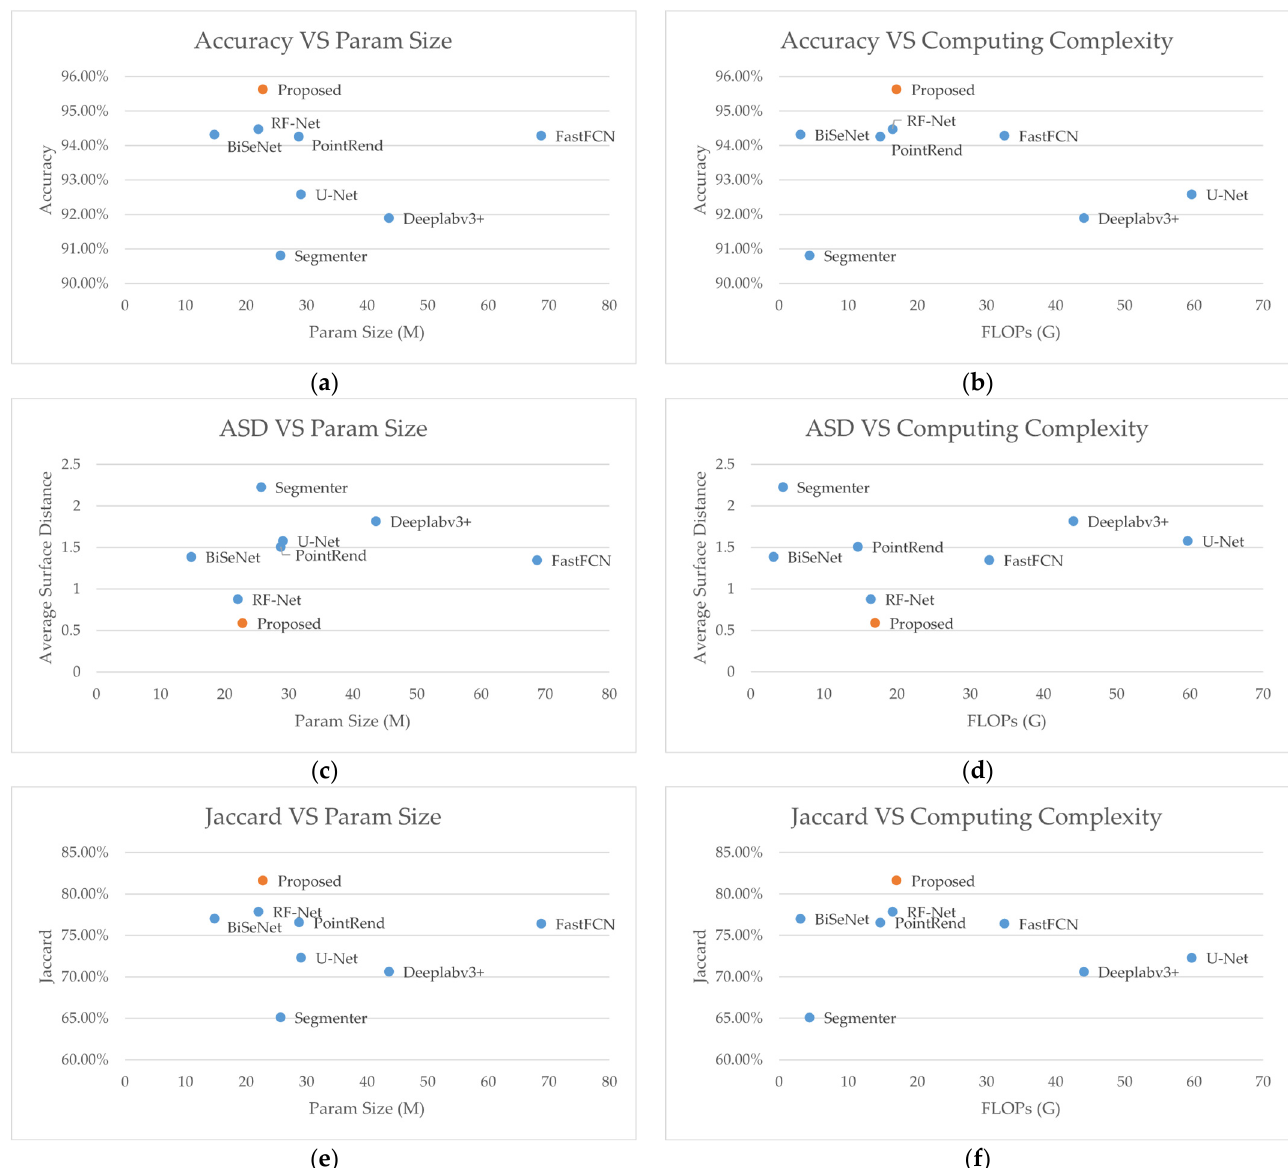
Figure 8. Performance requirements versus segmentation capabilities. (a) accuracy versus param size; (b) accuracy versus computing complexity; (c) ASD versus param size; (d) ASD versus computing complexity; (e) Jaccard score versus param size; (f) Jaccard score computing complexity.